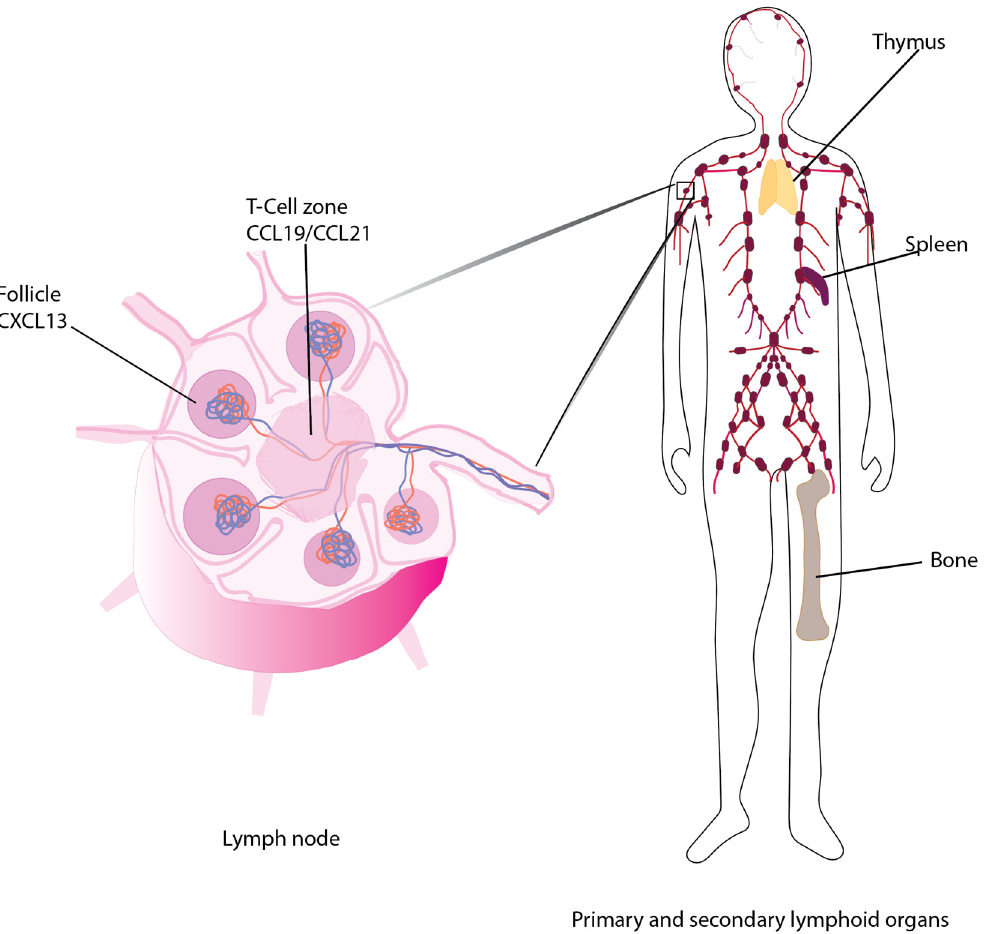
Figure 2. CCR7 promotes chemotaxis of cells to the T-cell zones of secondary lymphoid